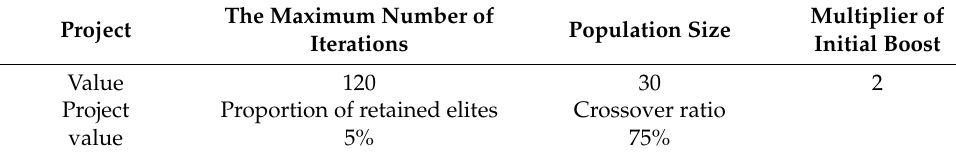
Table A1. Parameter setting of Galapagos.